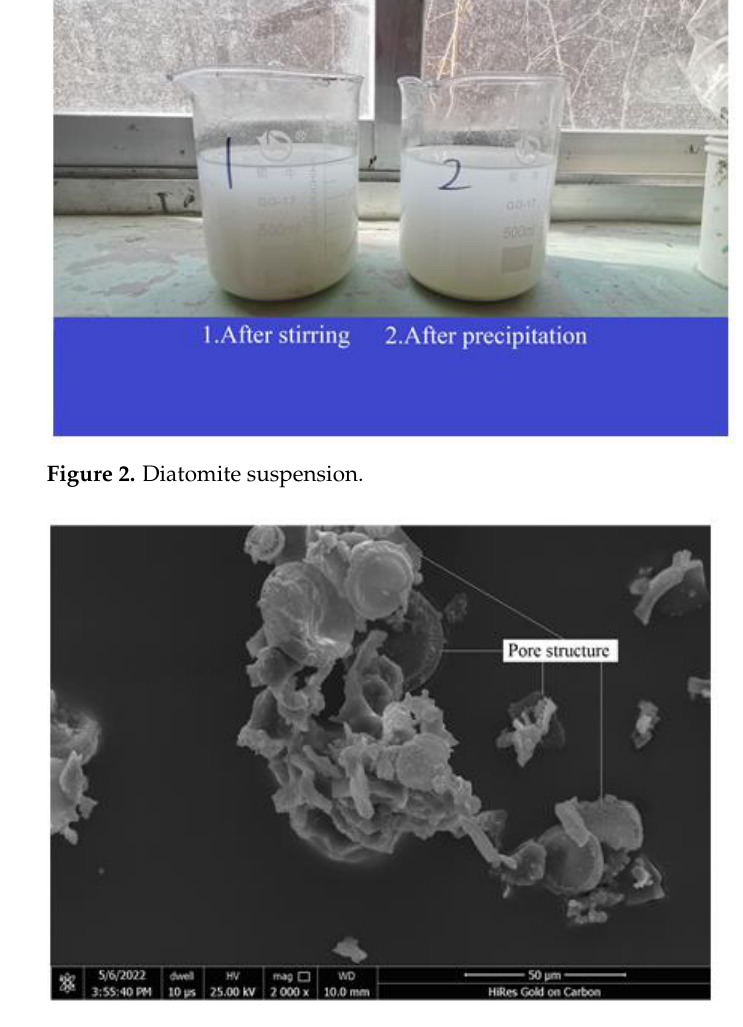
Figure 3. Microstructure of diatomite (×2000).